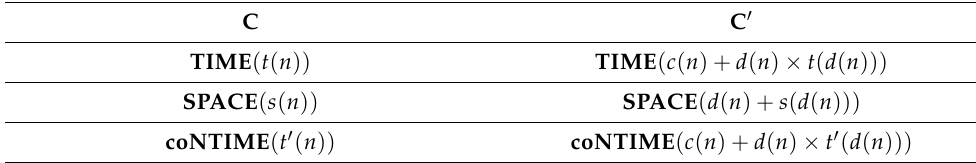
Table 1. Complexity bounds for deciding the combination of ctx -extensible logics. C C